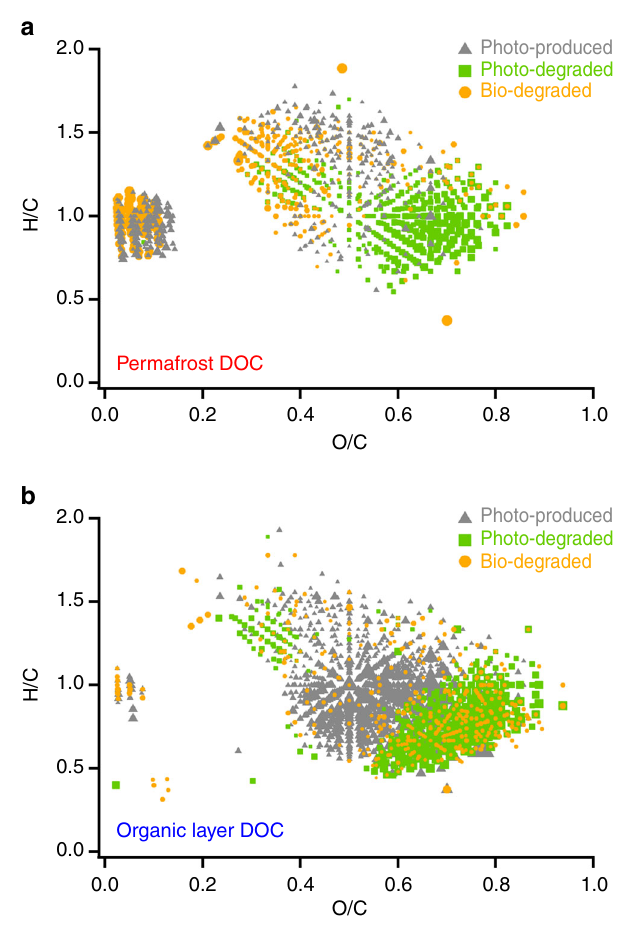
Fig. 1 Changes to dissolved organic carbon chemical composition by microbes or sunlight. van Krevelen diagrams of formulas in a permafrost dissolved organic carbon (DOC) and b organic layer DOC that were labile to microbes in the dark ( orange circles ), produced by sunlight ( gray triangles ), or degraded by sunlight ( green squares ). Formulas were categorized as degraded by microbes, produced by sunlight, or degraded by sunlight based on changes in relative formula intensities calculated using the 95% con fi dence interval of experimental triplicates. The size of the symbol is proportional to the change in relative intensity. Photo-produced and photo-degraded formulas were previously reported 14